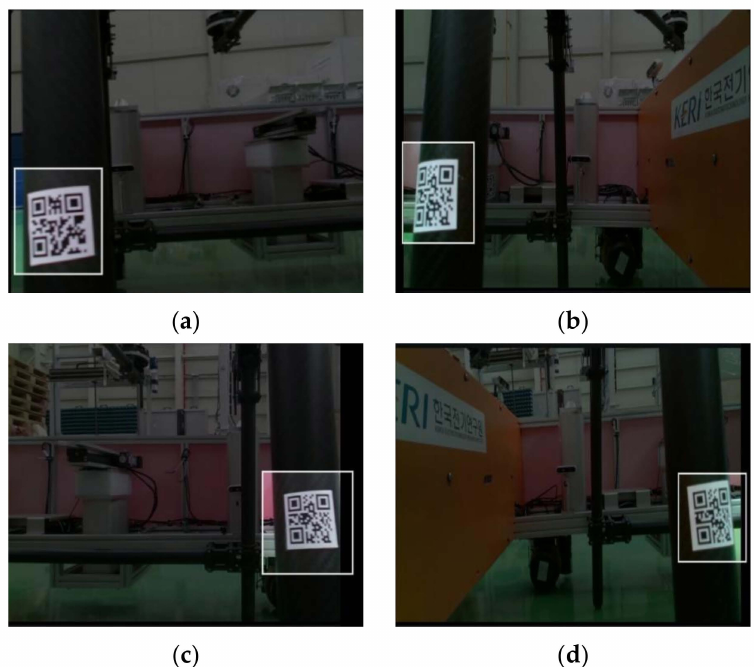
Figure 16. Precision-control marker where a rotation error occurs. ( a ) Image shot from the left front camera (angular error: 1.24 ◦ , distance of 1.3 cm); ( b ) image short from the left rear camera (angular error: 1.29 ◦ , distance: 3.7 cm); ( c ) image shot from the right front camera (angular error: 1.48 ◦ , distance: 3.1 cm); ( d ) image shot from the left front camera (angular error: 1.44 ◦ , distance error: 1.21 cm).